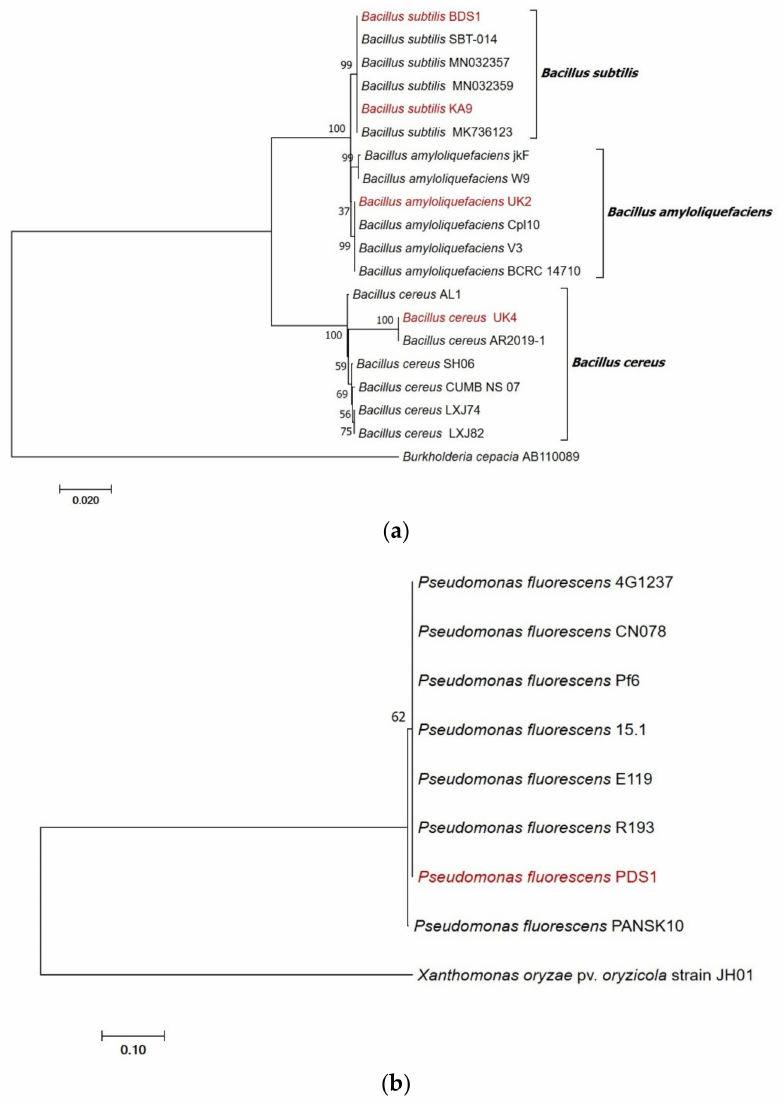
Figure 9. ( a ) Phylogenetic tree highlighting the position of Bacillus subtilis strain BDS1 , Bacillus cereus strain UK4, Bacillus subtilis strain KA9 and Bacillus amyloliquefaciens strain UK2 relative to other type strains within the Bacillus genus. Sequences were aligned using Clustal-W and phylogenetic inferences were obtained using the maximum-likelihood method within MEGA 6. Numbers at nodes are percentages of bootstrap values obtained by repeating analysis 1000 times to generate a majority consensus tree. Burkholderia cepacia strain AB110089 was used as an outgroup. ( b ) Phylogenetic tree highlighting the position of Pseudomonas fluorescens strain PDS1 relative to other type strains within Pseudomonas genus. Sequences were aligned using Clustal-W and phylogenetic inferences were obtained using the maximum-likelihood method within MEGA 6. The numbers at nodes are percentages of bootstrap values obtained by repeating analysis 1000 times to generate a majority consensus tree. Xanthomonas oryzae pv. Oryzicola strain JH01 was used as